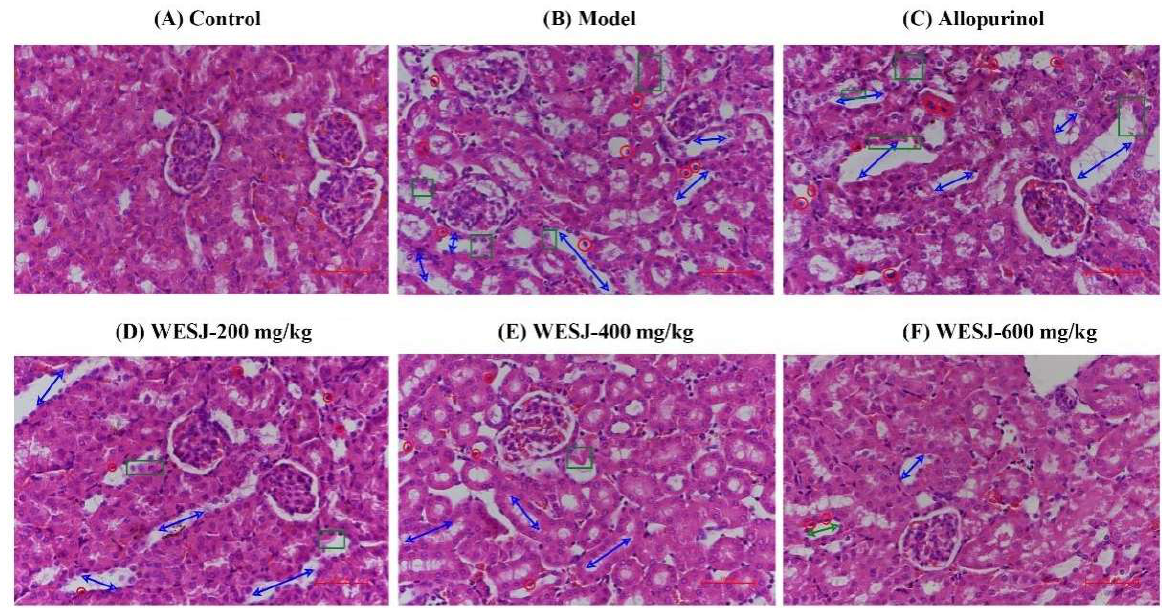
Figure 5. Renal sections for H&E staining (magnification, 400×). Note: renal tubule dilation (blue arrows); pyknotic or necrotic nuclei (red circles); lesion, necrosis, or exfoliation of the tubular epithelium (green squares).